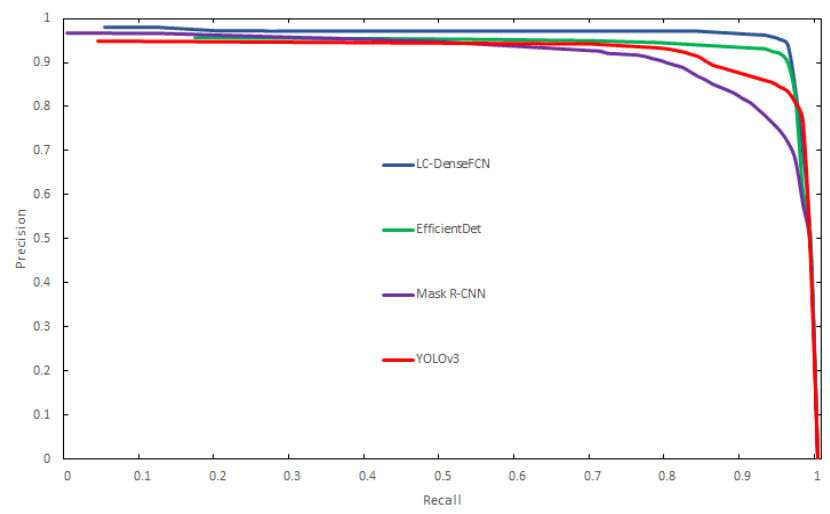
Figure 7. Comparisons of precision–recall curves for four detection cases. Table 2. Comparison of counting results with three competing